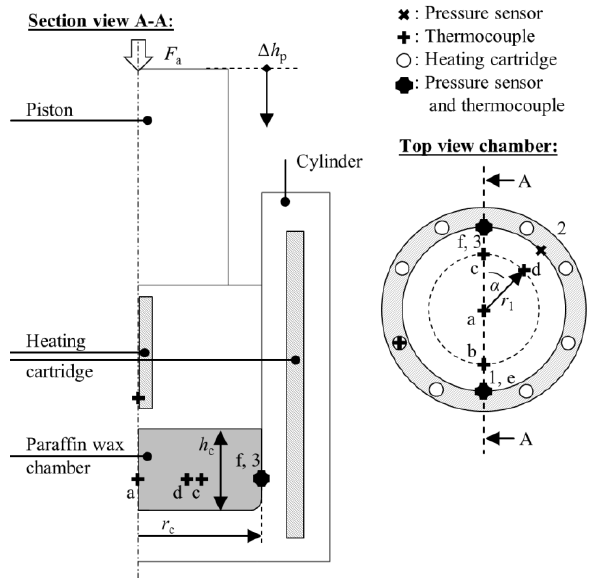
Figure 2. Piston-cylinder test set-up.